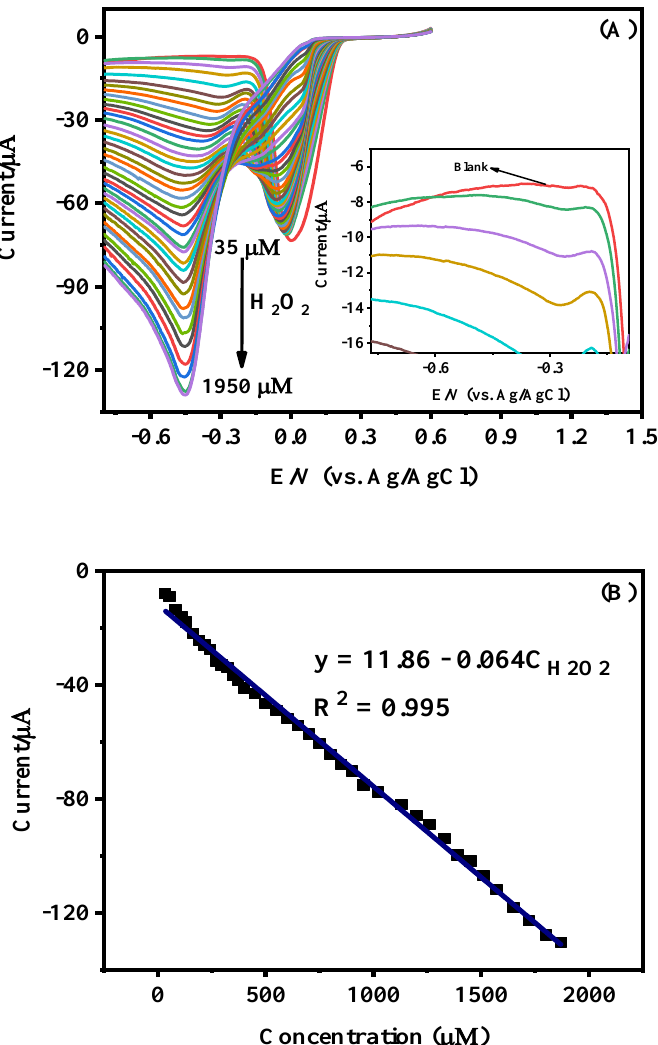
Figure 7. ( A ) CV of AgNPs-rGO/GCE recorded at a scan rate of 50 mV/s at different concentrations of H 2 O 2 (from 35 µ M to 1.95 mM) in 0.1 M PBS (pH 7.0). ( B ) Calibration curve for H 2 O 2 , determined taking into account the cathodic peak current at − 0.45 V. The standard deviation of response calculated from data in the calibration curve is 2.464 μA.